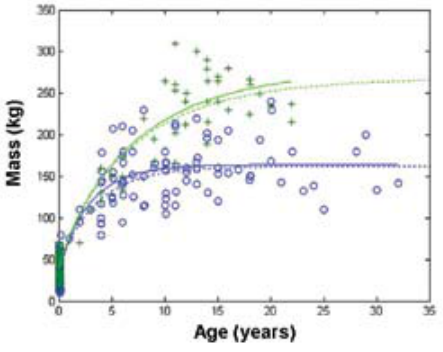
Fig. 3. Change in mass at age of female (o) and male (+) Icelandic grey seals (Halichoerus grypus) described with the von Bertalanffy model for growth (solid lines). Calculated mass at age, by using esti - mated standard length at age and the power function of weight on length (dotted lines), is presented for